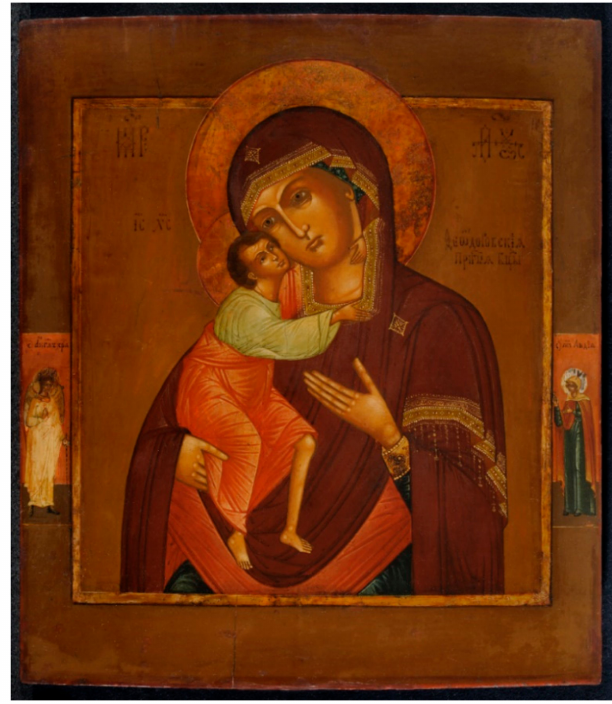
Figure 6. Mother of God of Theodor, Russia, workshop of the Old Believers, end of 18th c., tempera on wood, 35 × 31.2 cm, National Museum in Warsaw, photo: Małgorzata